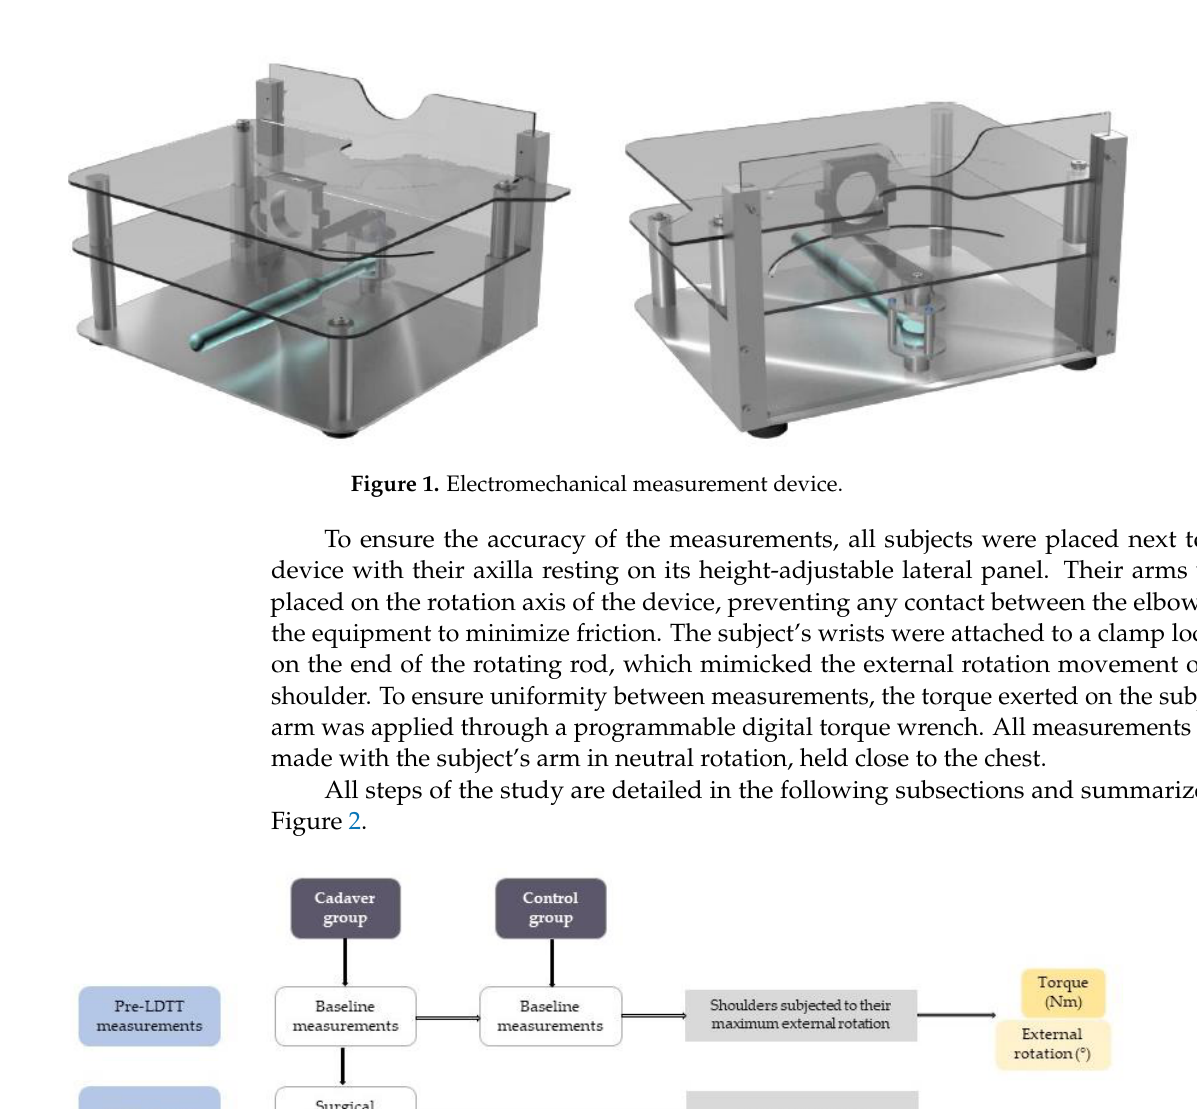
Figure 1. Electromechanical measurement device.